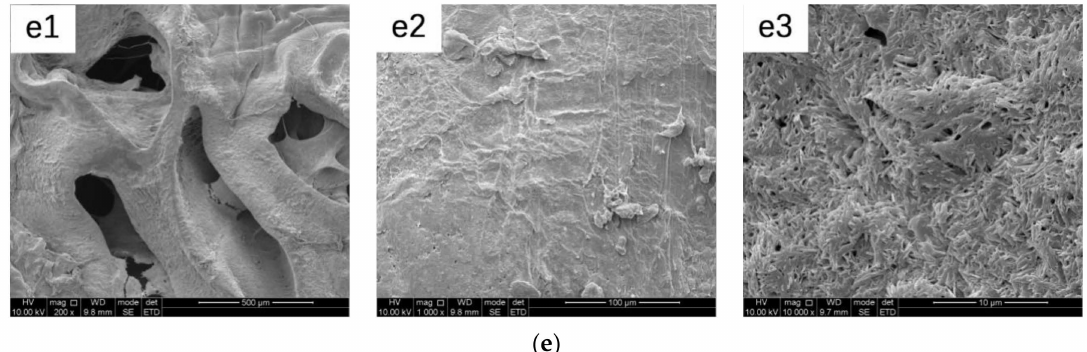
Figure 8. SEM images of ( a ) PTMG / PEG 100 / 0 (a1 200 × , a2 1000 × , a3 10000 × ); ( b ) PTMG / PEG 75 / 25 (b1 200 × , b2 1000 × , b3 10000 × ); ( c ) PTMG / PEG 50 / 50 ((c1) 200 × , (c2) 1000 × , (c3) 10000 × ); ( d ) PTMG / PEG 25 / 75 ((d1) 200 × , (d2) 1000 × , (d3) 10000 × ); ( e ) PTMG / PEG 0 / 100 ((e1) 200 × , (e2) 1000 × , (e3) 10000 ×